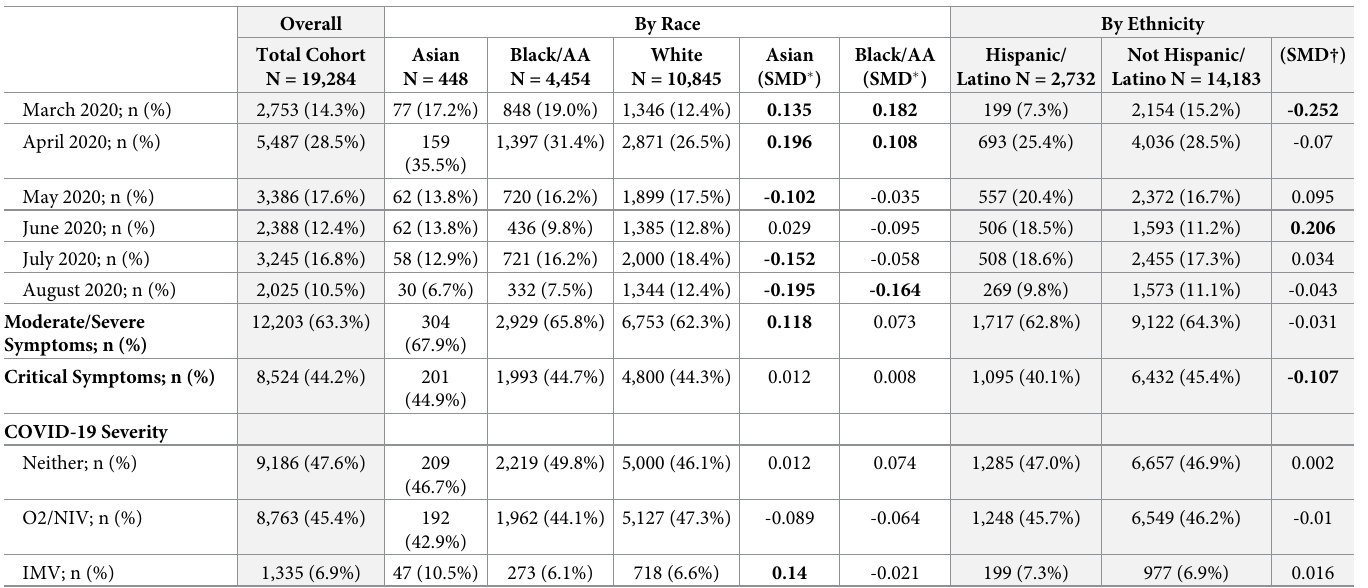
Latino patients represented 14.2% (N = 2,732) of the population, while 73.5% of patients (N = 14,183) were Not Hispanic/Latino (2,329, or 12.1% had a missing ethnicity). In total, we had 15,745 (81.6%) patients with non-missing race, and 16,915 (87.7%) patients with non- missing ethnicity (S2 Fig).